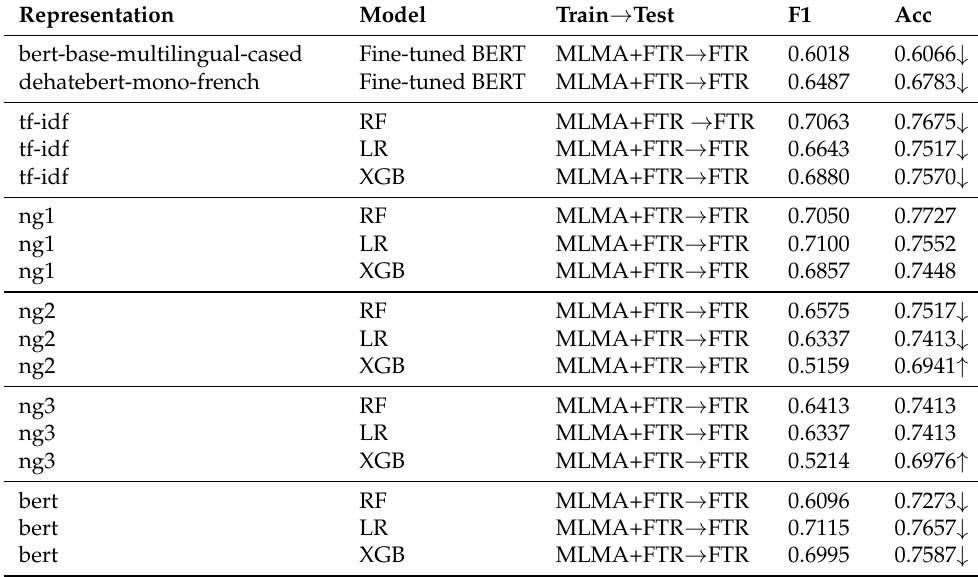
Table 8. Results of multi-domain evaluation (accuracy and F1).